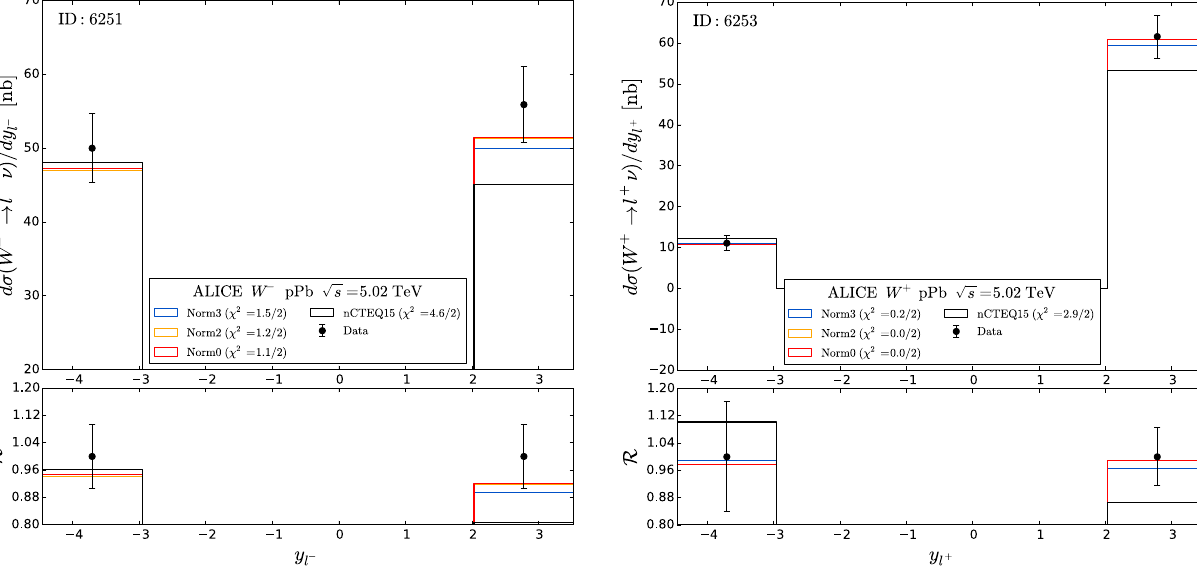
Fig. 5 Comparison of data with theory for ALICE W ± production. The normalization shifts are applied to the theory so we can compare all the results on a single plot; the data is unaltered. For reference, ALICE Run I { W − , W + } = { 6251 , 6253